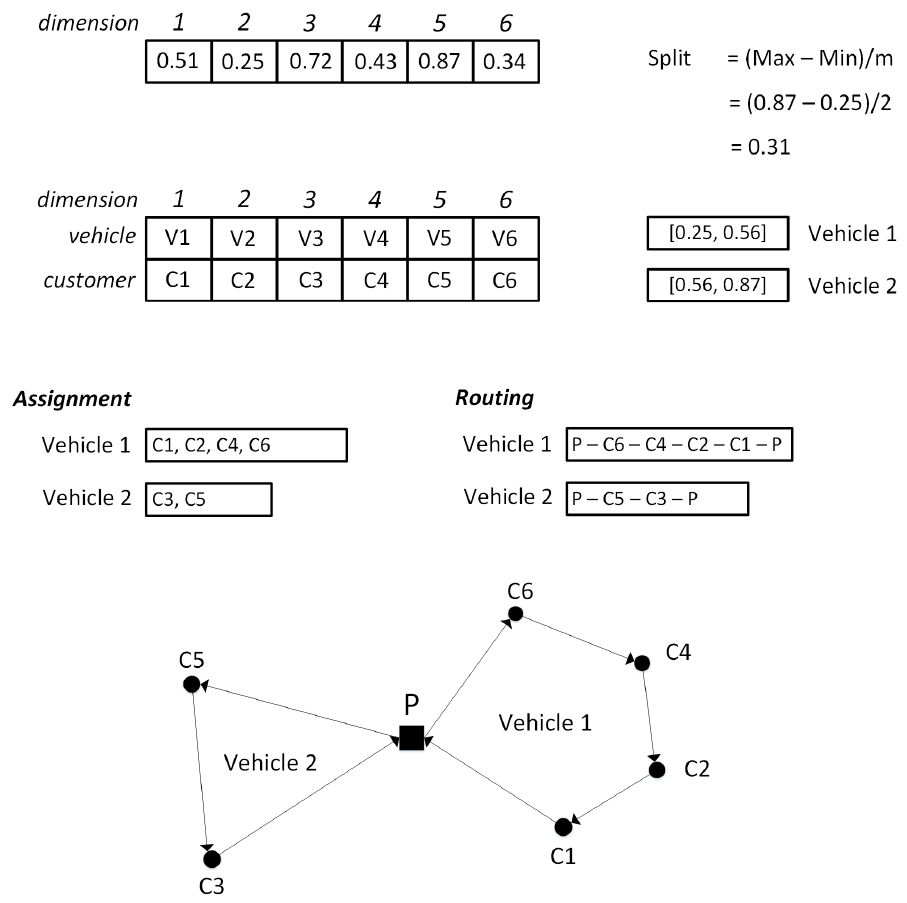
Figure 7. Decoding procedures to transform a D -dimensional solution into a vehicle routing solution.